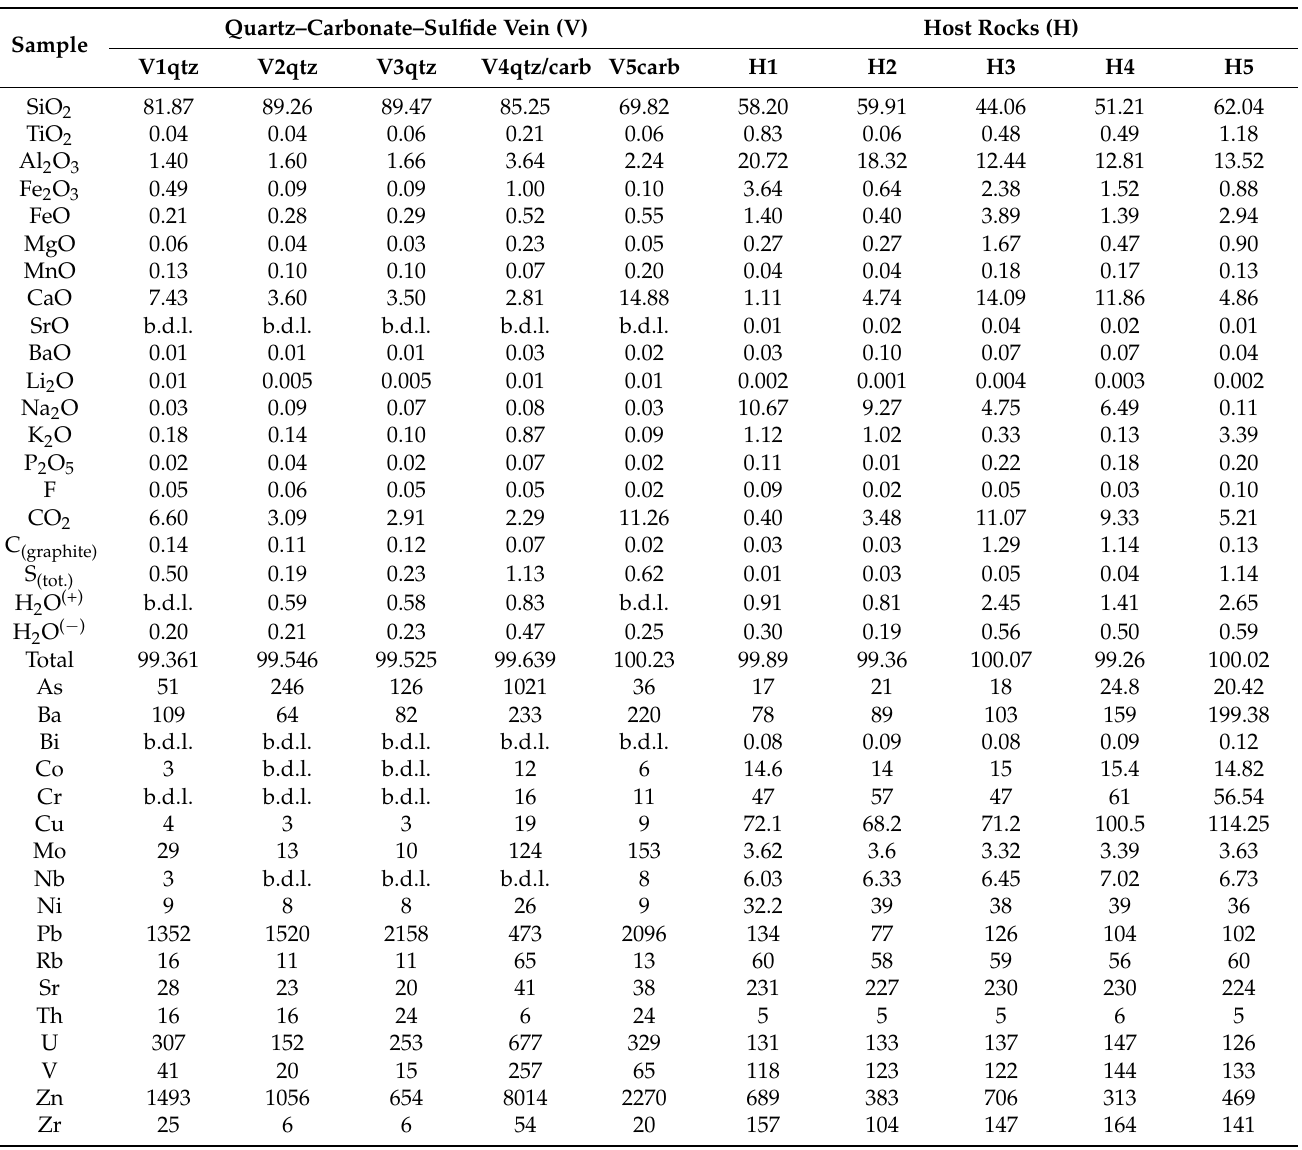
Table 1. Concentration of the main and trace elements in the quartz–carbonate–sulfide vein and in host rocks. Main elements are expressed in wt.%, and concentrations of trace elements are expressed in